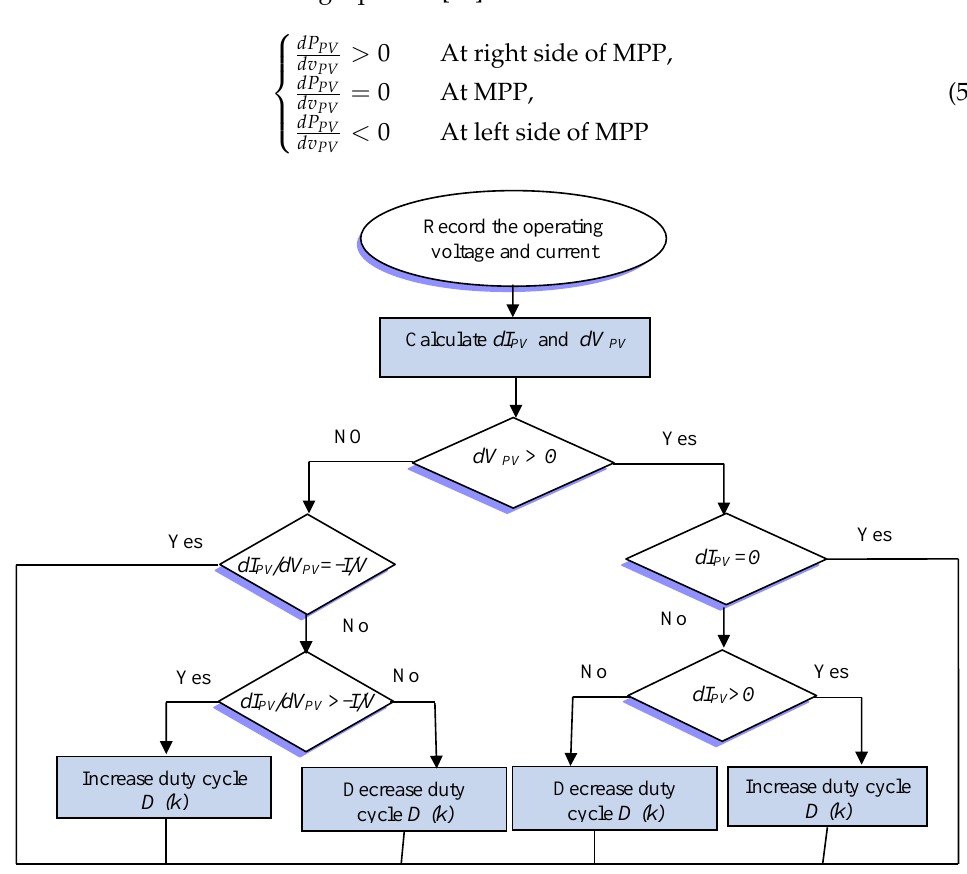
Figure 2. Flowchart of INC based tracker